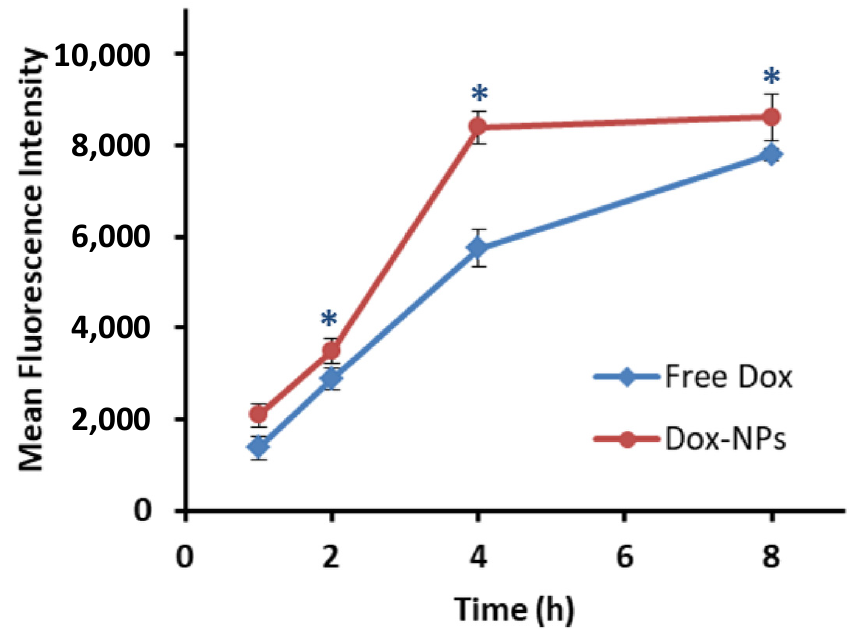
Figure 6. The cellular uptake of Dox and Dox-NPs into HT-29 cells at different time points (* Signifi- cant difference at 95% CI). The MFI was calculated from 10,000 events analyzed with the laser line of 488 nm by flow cytometer.